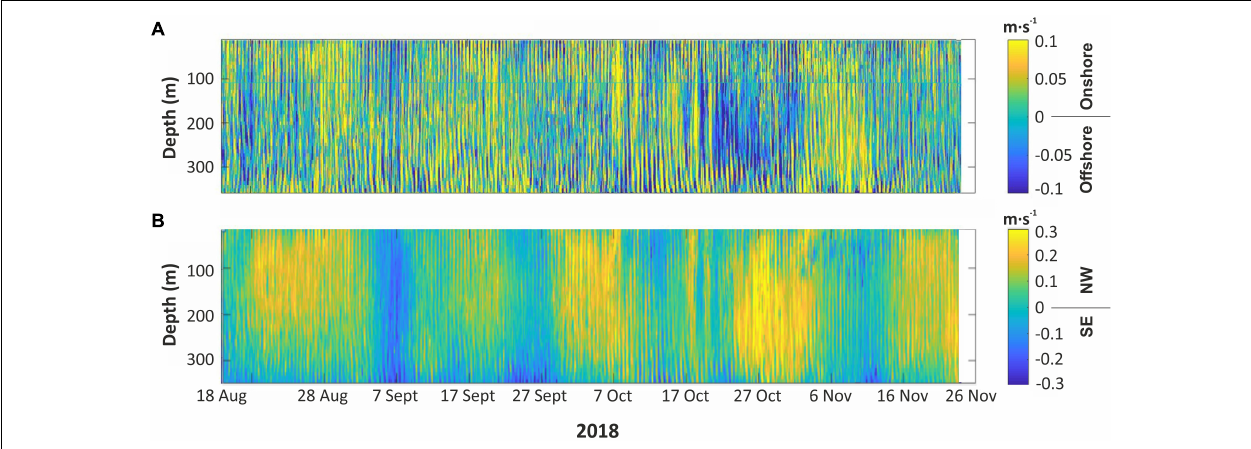
FIGURE 7 | (A) Across-margin and (B) along-margin velocity components, in m · s – 1 , measured with the 75 kHz Acoustic Doppler Current Profiler (ADCP) installed at the BUS Instrument Platform during the study period, spanning from the 14th of August to the 23rd of November 2018. Note the change in scale for the along-margin component. For interpretation of the references to color in this figure legend, the reader is referred to the web version of this article.